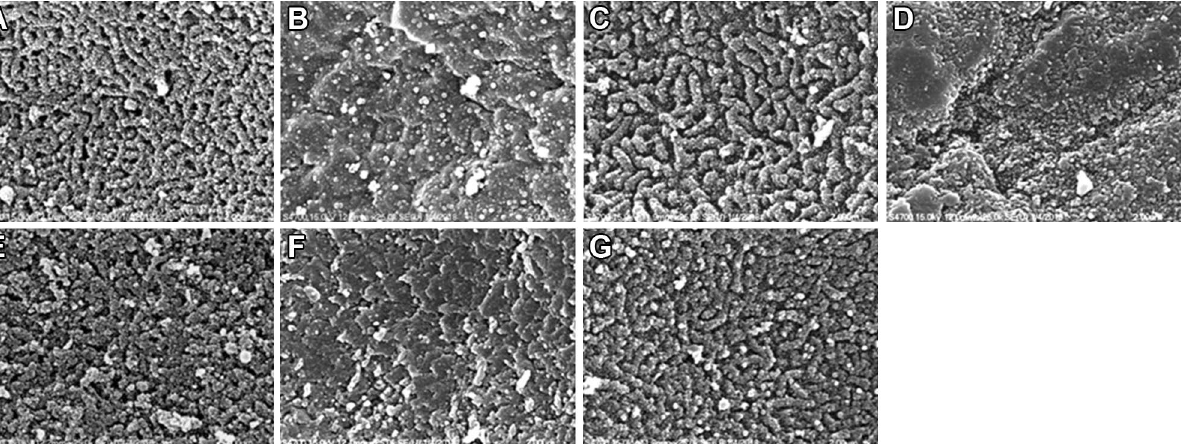
Figure 6. Scanning electron microscopy of cornea demonstrated that the microvilli of corneal epithelium were well-preserved in the non-dry control (A) but were mostly lost in the dry eye mice (B) . Topical application of ADSC-CM (C) , < 10 kD fraction of ADSC-CM (E) , or < 3 kD fraction of ADSC-CM (G) preserved the microvilli best from dry damage. In contrast, those treated with topical > 10 kD fraction of ADSC-CM (D) or > 3 kD (F) did not have good surfaces covered by microvilli. Magnification: ×25,000 (N =